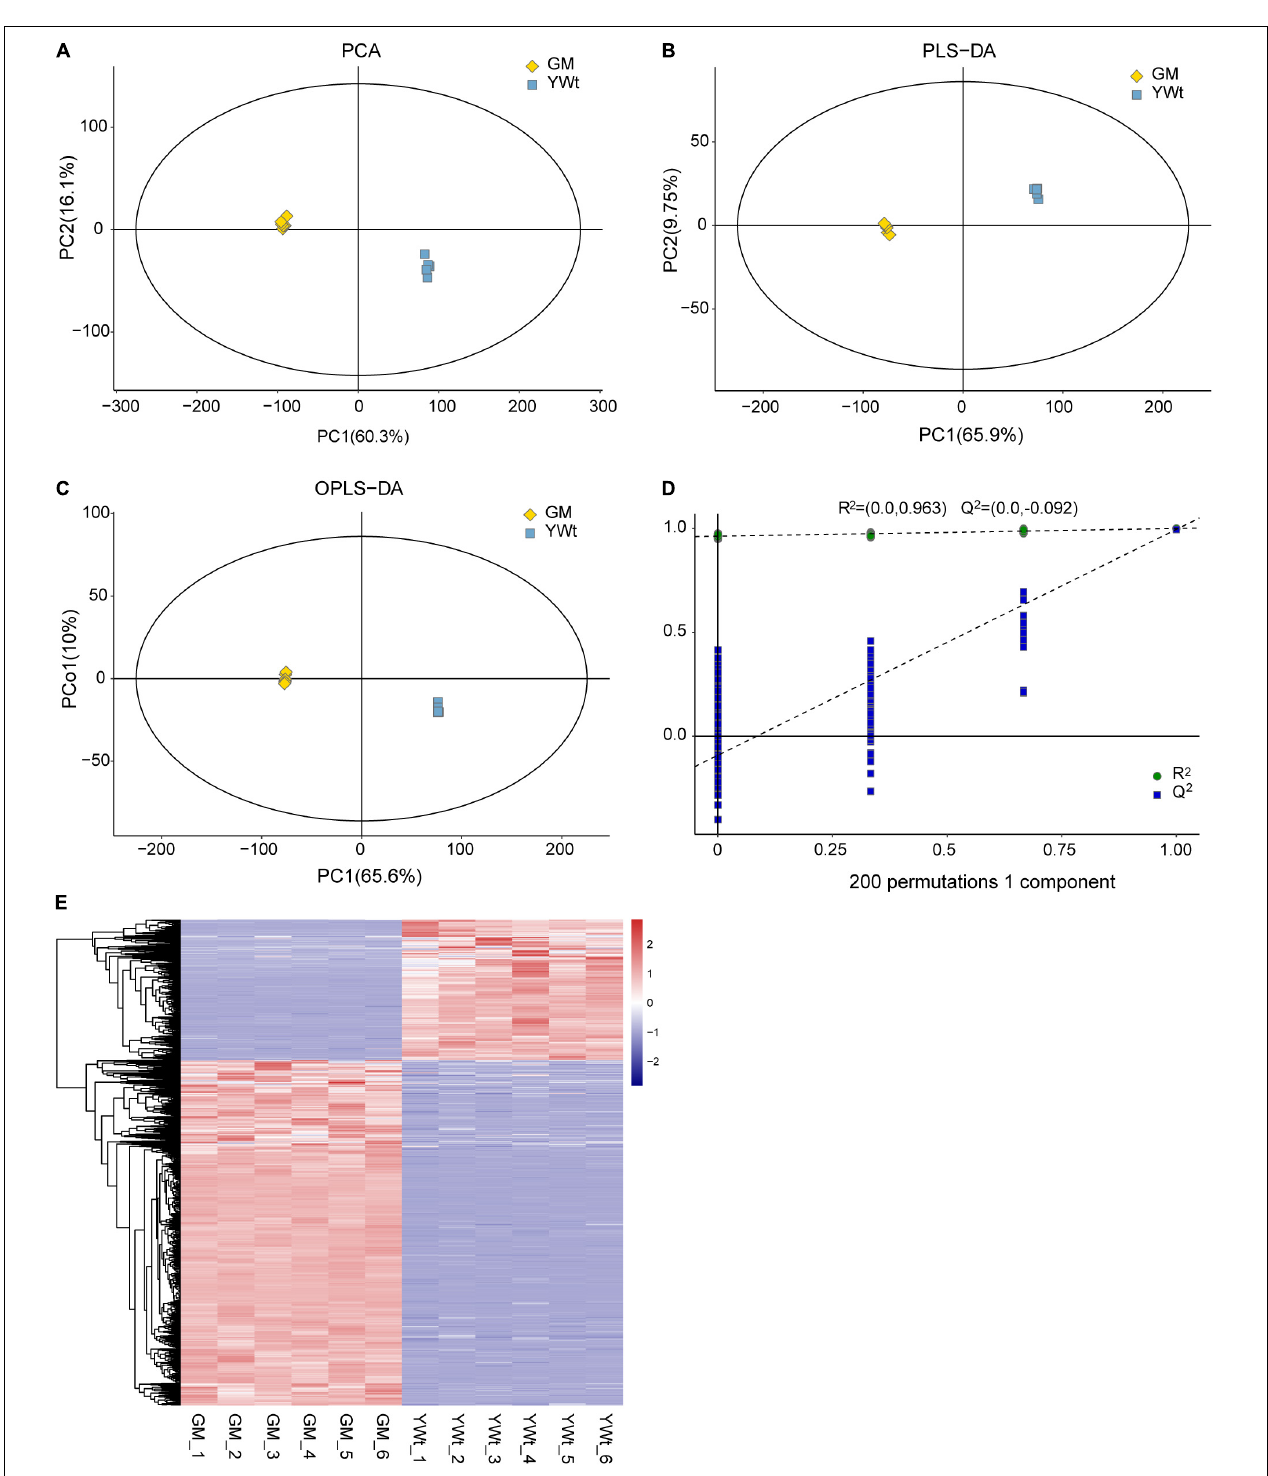
FIGURE 1 | Multivariate statistical analysis of the metabolome and differentially synthesized metabolites (DSMs). Plots of principal component analysis (PCA) (A) , partial least squares discriminant analysis (PLS-DA) (B) , and orthogonal PLS-DA (OPLS-DA) (C) . (A,B) The x - and y -axes represent the first (PC1) and the second (PC2) principal components, respectively; (C) the x - and y -axes represent predictive principal components and orthogonal principal components, respectively. (D) The 200-response sorting tests of the OPLS-DA model. (E) Hierarchical clustering heatmap of DSMs. Each column and row represent a sample and a differentially expressed unigene (DEG), respectively, and the colors indicate the expression levels of DSMs. GM, evergreen mutant; YWt, yellowish-brown needles in winter; GM_1, GM_2, GM_3, GM_4, GM_5, and GM_6 represent six repetitions.